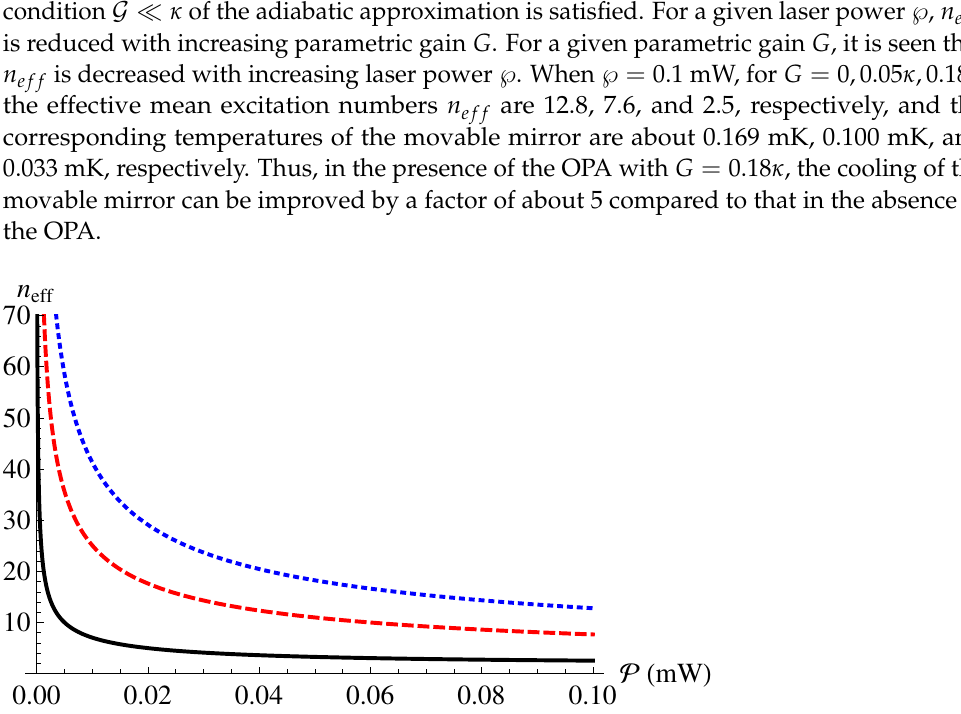
Figure 2. Plot of the effective mean vibrational number n ef f in the movable mirror as a function of the power ℘ of the driving laser for different parametric gains G = 0 (blue dotted), 0.05 κ (red dashed), and 0.18 κ (black solid) when the parametric phase is θ =